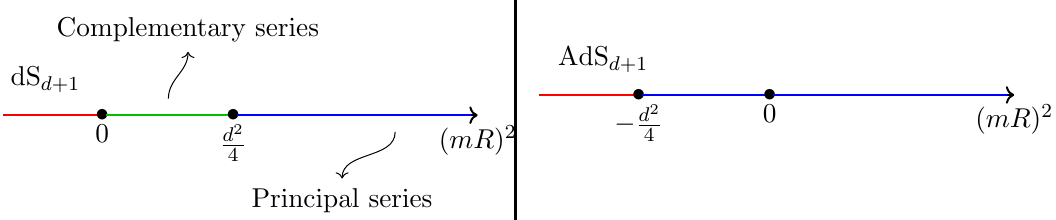
Figure 1 . Unitary (blue and green), and non-unitary (red) regions for the squared mass of a scalar (cid:12)eld in de Sitter (left) and anti-de Sitter space